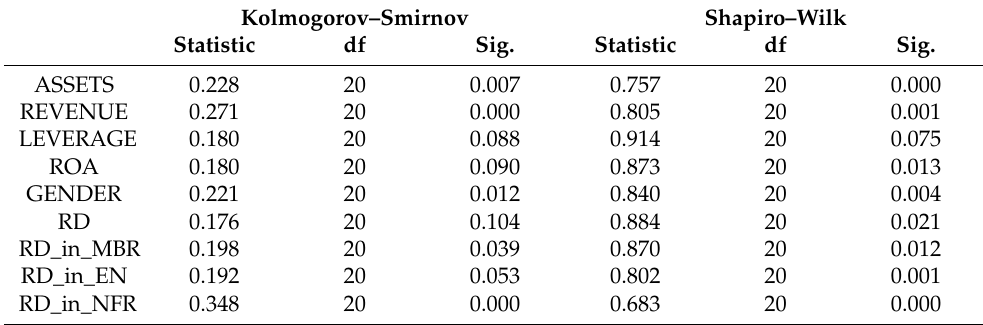
Table 8. Test of Normality Distribution.